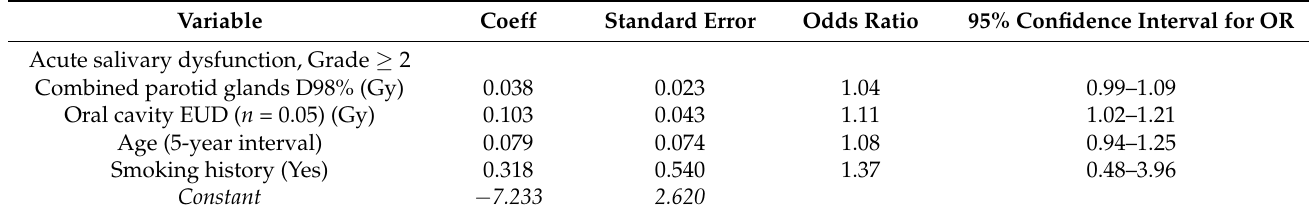
Table 3. Multivariate logistic model for grade ≥ 2 acute salivary